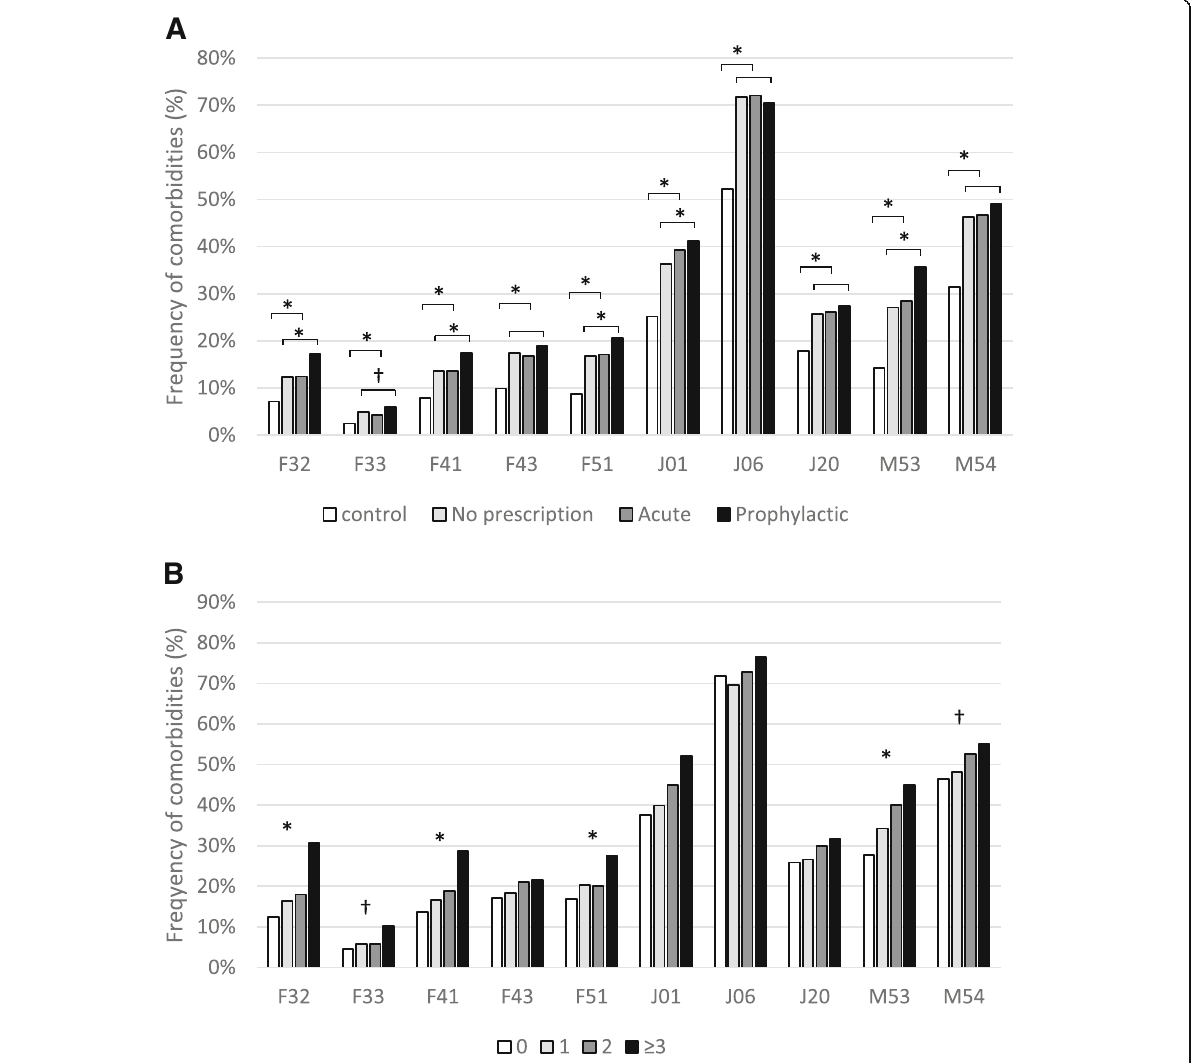
Fig. 4 a The frequency of comorbidities in controls (white) and patients with migraine (G43*) according to prescriptions of migraine medications [no prescription (light grey), acute (dark grey), prophylactic prescriptions (black)]. Significance is indicated between controls and migraine patients, as well as between migraine groups. b Comorbidities by prophylactic treatment line [no prophylactic prescriptions (white); 1st prophylactic treatment line (light grey); 2nd prophylactic treatment line (dark grey); 3rd or more treatment line (black)]. Significance is indicated between four groups. * p <0.001; † <0.005. F32 – depression single episode; F33 – depression recurrent; F41 – anxiety; F43- stress reaction; F51 – sleep disorder; J01- sinusitis; J06 – upper respiratory infections; J20 – bronchitis; M53 – dorsopathy; M54